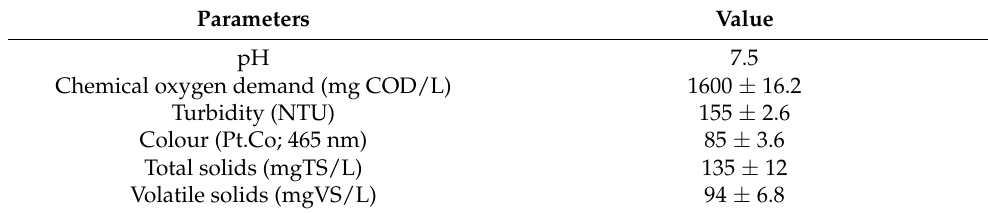
Table 1. Composition of wastewater sample.